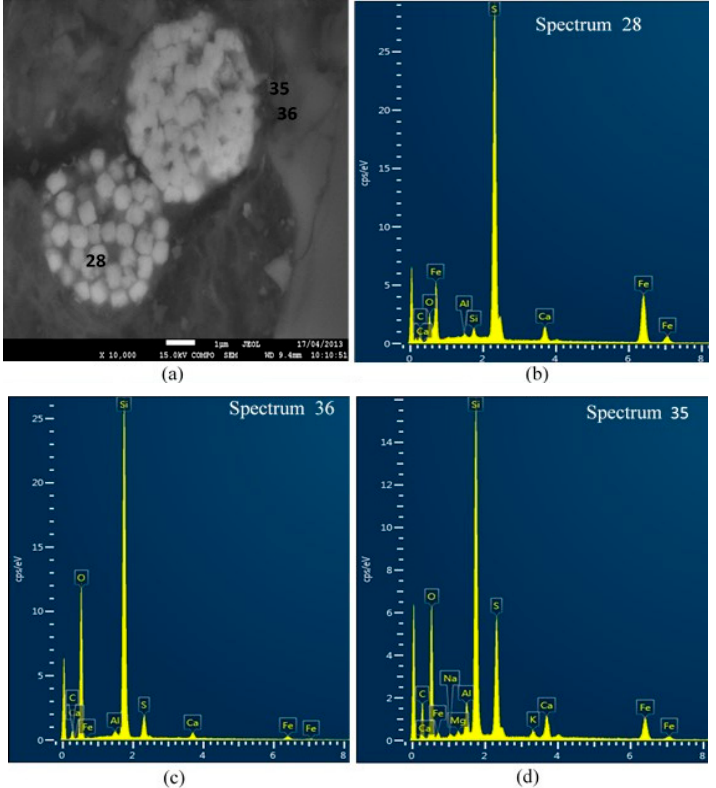
Figure 6. ( a ) Back-scattered electron imaging (BEI) of ASS containing 4 wt % additional pyrite and treated with 15% lime and 20 wt % slag 365 days curing ( b ) energy dispersive spectroscopy (EDS)spectrum at point 28 (pyrite); ( c ) EDS spectrum at point 36 (silica) and ( d ) EDS spectrum at point 35 (thaumasite-ettringite phase).